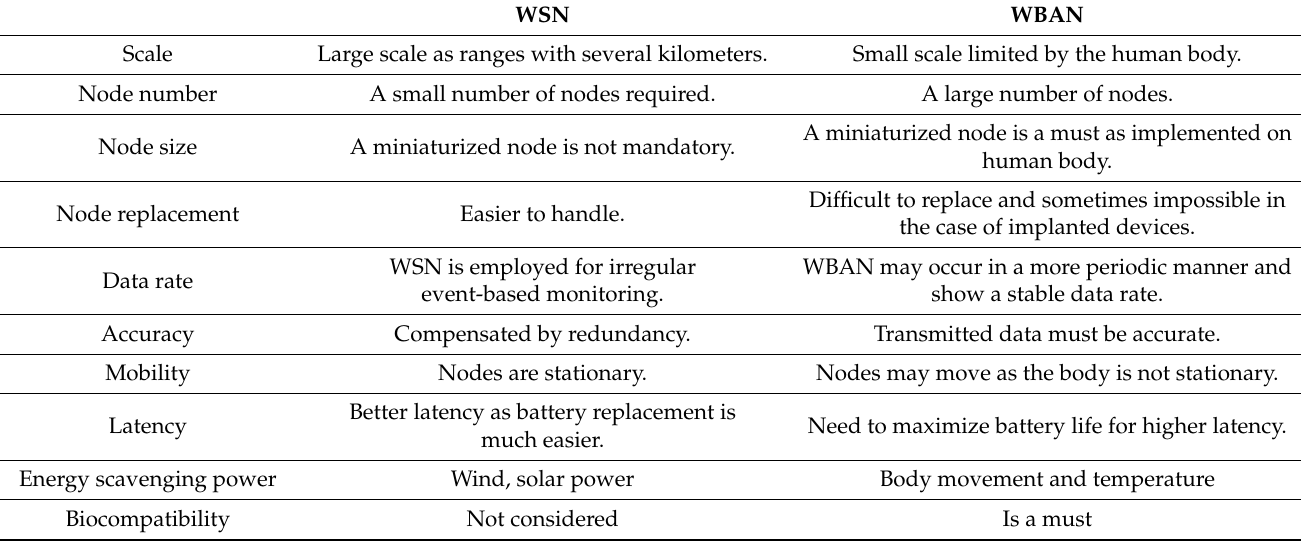
Table 3. The general differences between WBAN and WSNE.